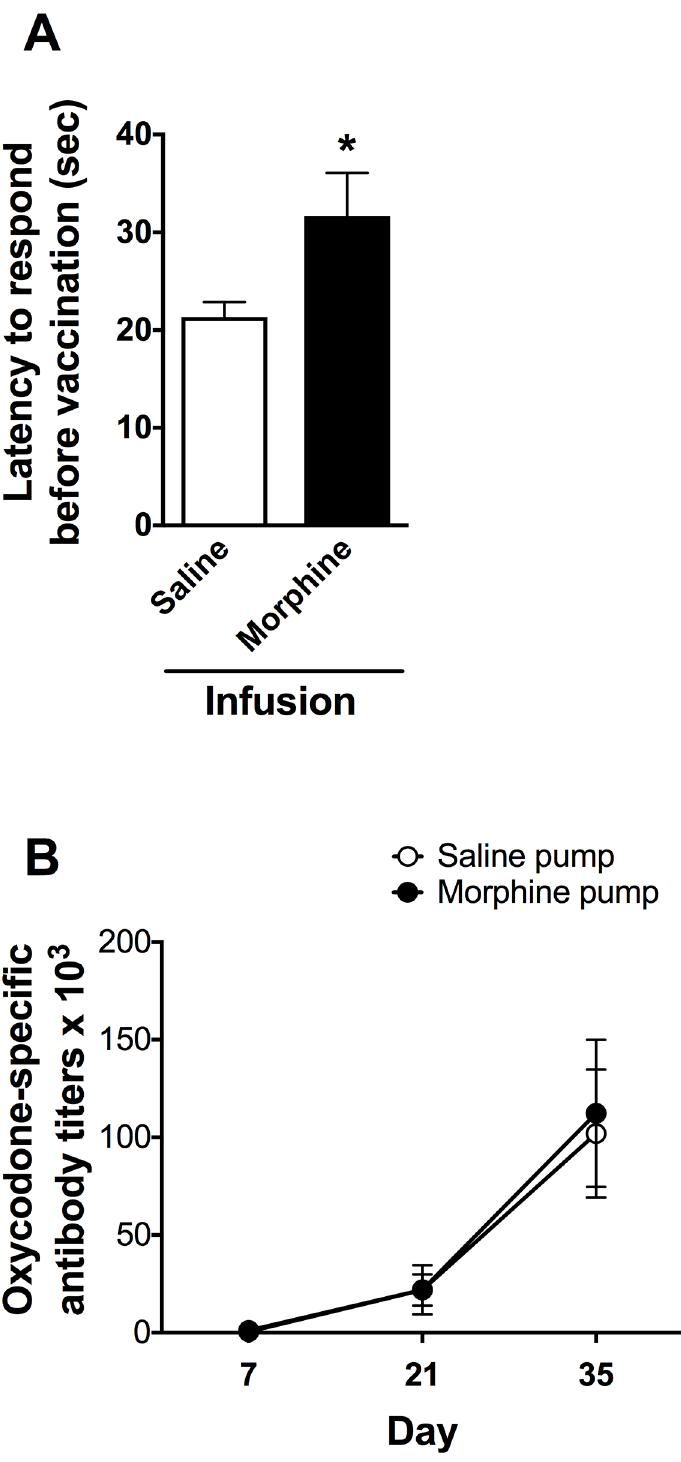
Fig 3. Concurrent morphine administration does not interfere with oxycodone vaccine immuno- genicity. A) Prior to vaccination,mice receivings.c. morphineinfusion(8 mg/kg/day) showeda significant increasein latency to respondin the hotplateantinociception test (mean ± SEM, * p < 0.05). This confirms that mice receiveda behaviorallyactive dose of morphinefor the followingexperiment: B) After initiation of vaccination, oxycodone-specific antibodytiters in serum did not differ betweenmice receivingmorphine